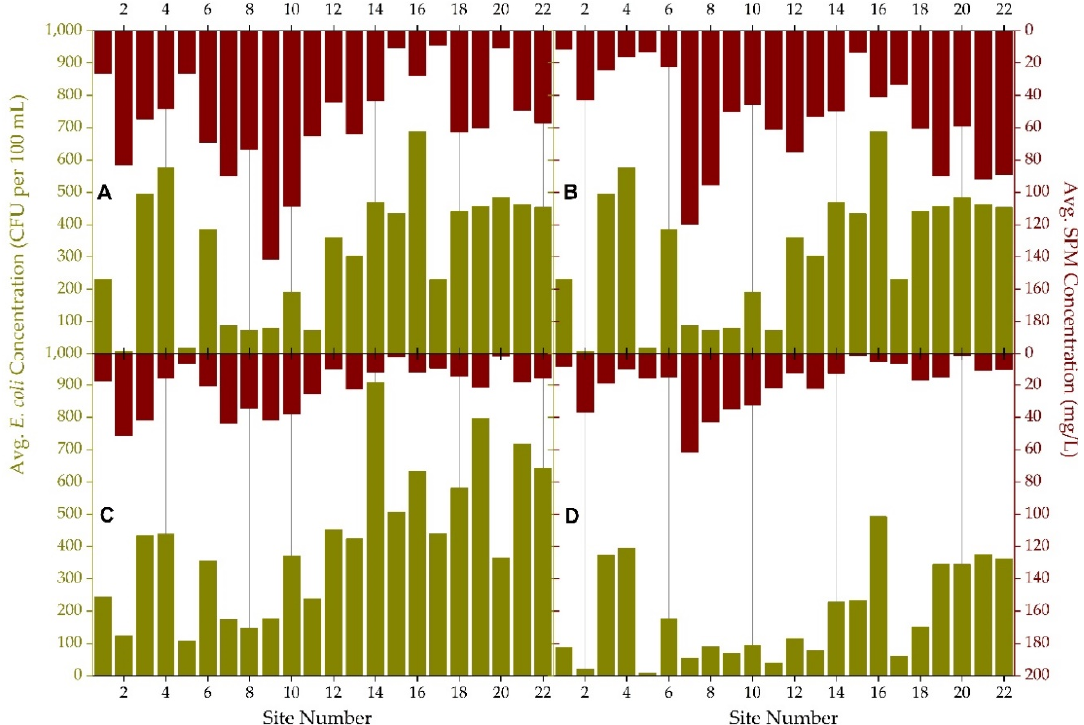
Figure 7. Quarterly average E. coli concentration (CFU per 100 mL) and SPM concentration (mg/L) at each sampling location (n = 22) during the study period (1/2/18–1/1/19) in West Run Watershed,